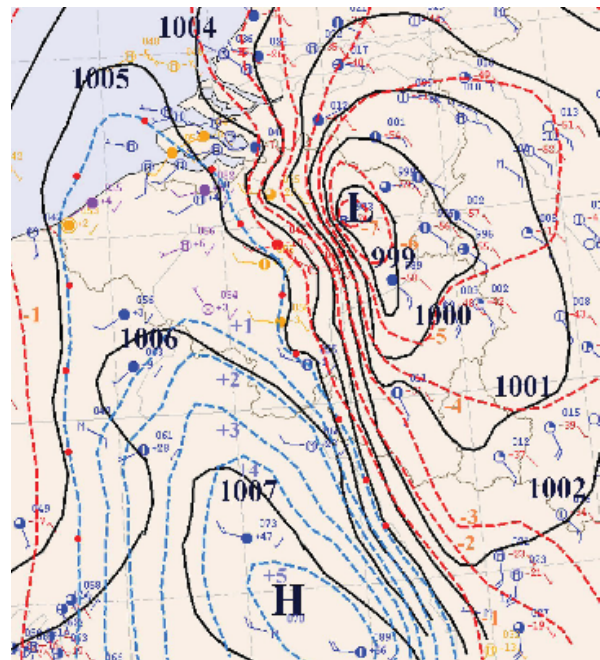
Figure 10. Synoptic analysis of 14 July 2010 15:00UTC. Isobars are solid black lines, dashed red and blue lines are isallobars, show- ing pressure drops and pressure increase respectively. Station obser- vations indicate wind direction and strength and the (partly) filled circles show the